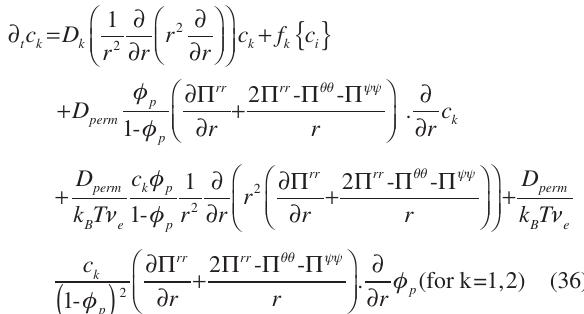
, with χ = 0.545303, 1 max